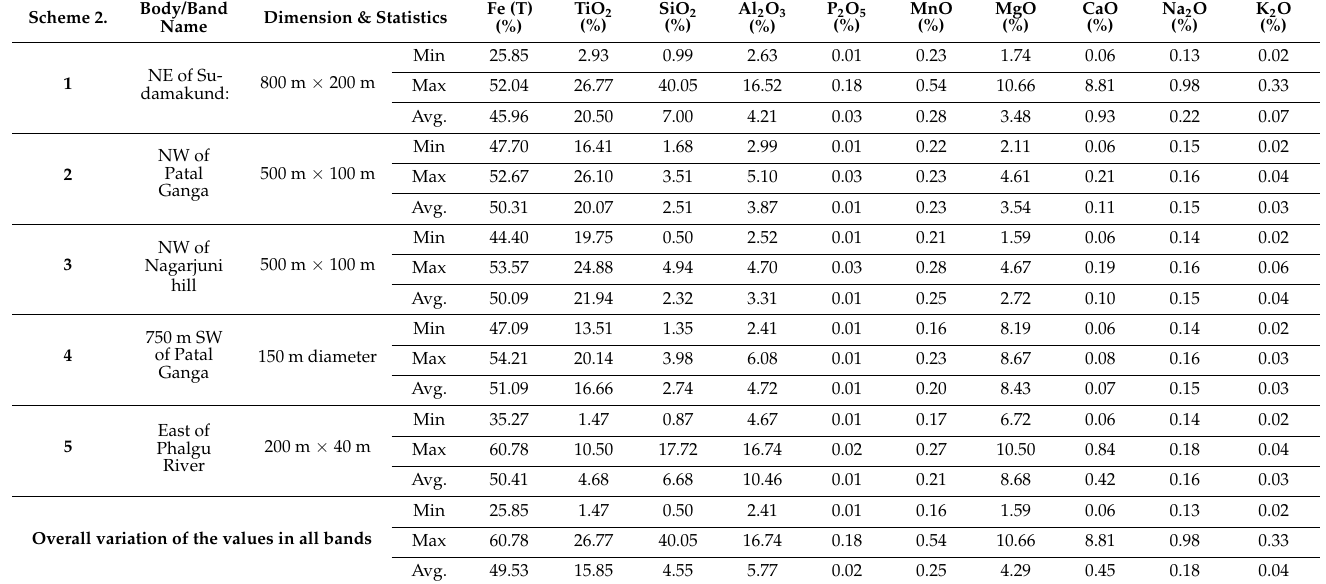
Table 5. Statistical analysis of major oxides composition of magnetite bodies